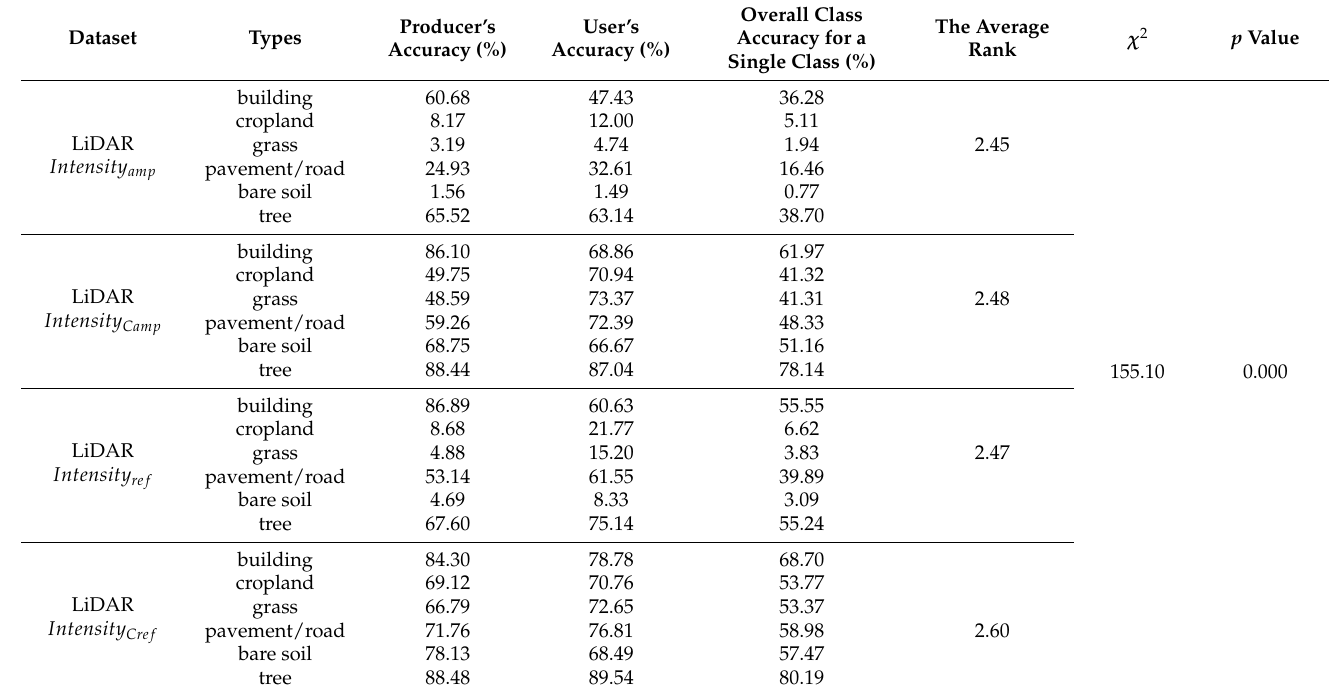
Table 4. Comparison of the classification accuracy of single type based on airborne LiDAR intensity before and after correction, test for the statistical significance of differences.